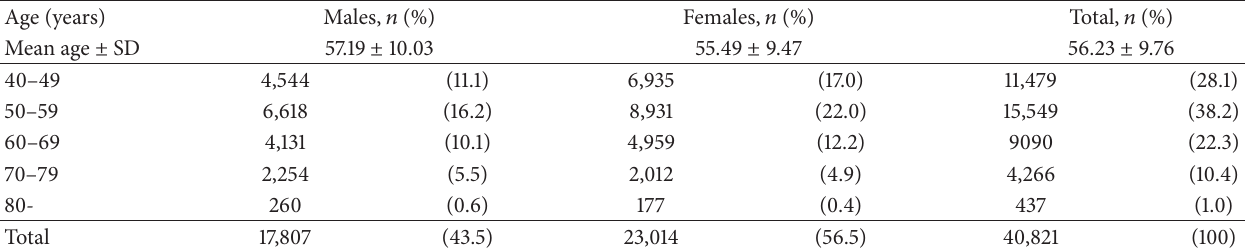
Values are presented as mean ± SD or 𝑛 (%).